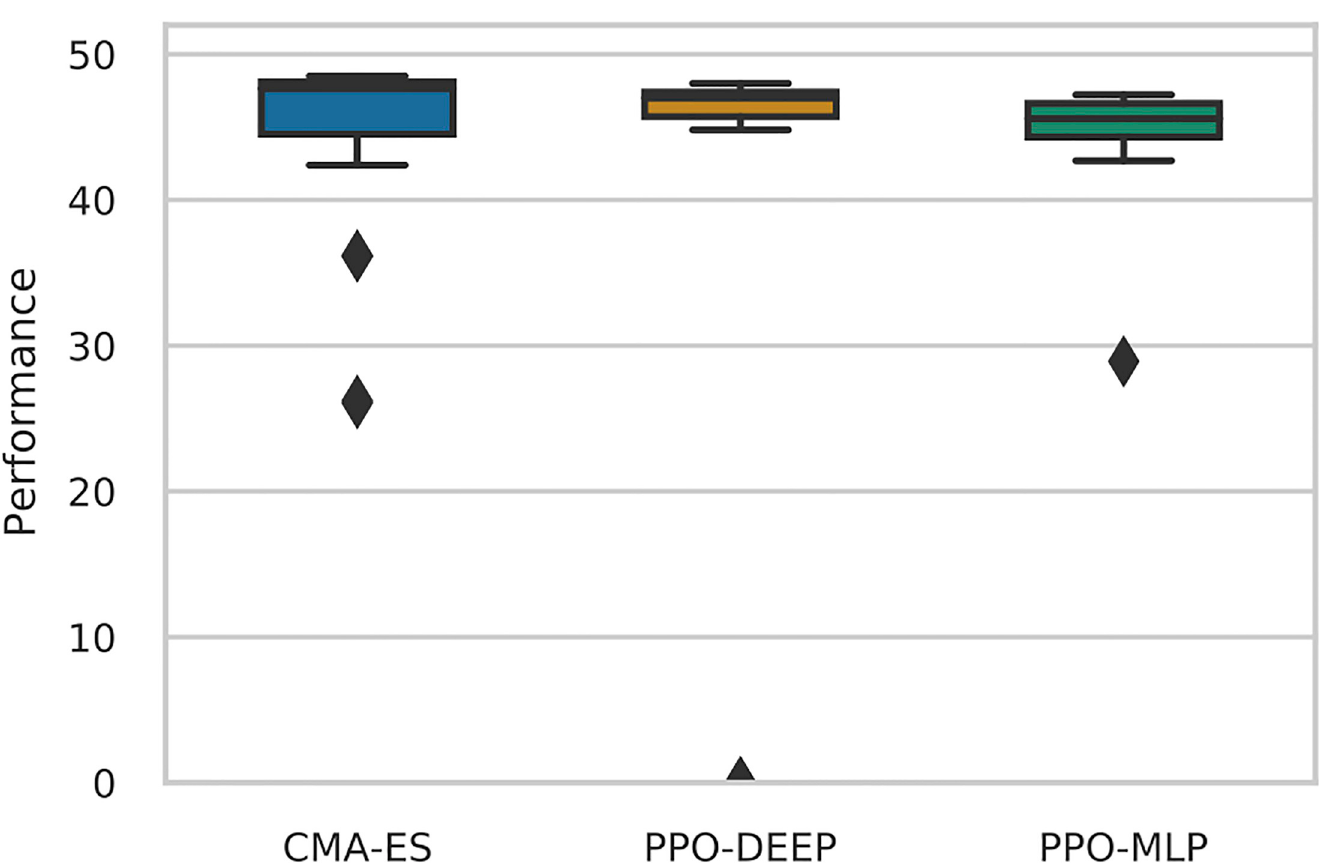
Fig 2. Performance of the best policies from CMAES, PPO-DEEP and PPO-MLP with p = 1.0 after re-evaluating policies for 1000 episodes without learning. Two-tailed Mann-Whitney U-test, n = 24, gives p -value = 0.12 (CMAES vs. PPO-DEEP), p -value = 0.019 (CMAES vs. PPO-MLP), p -value = 0.018 (PPO-DEEP vs. PPO-MLP). Median values and Median Absolute differences are: CMAES (median = 47.64, MAD = 4.72) is only slightly more than that of PPO-DEEP (median = 46.99, MAD = 13.04) and PPO-MLP (median = 45.58, MAD = 1.86).